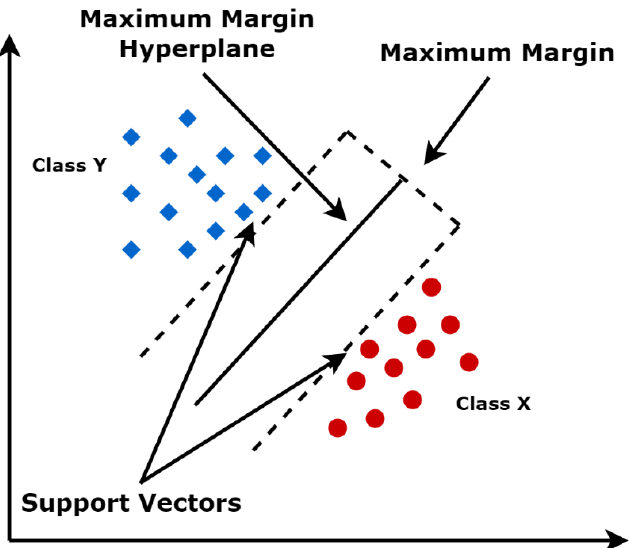
Figure 3. Support vector machine.